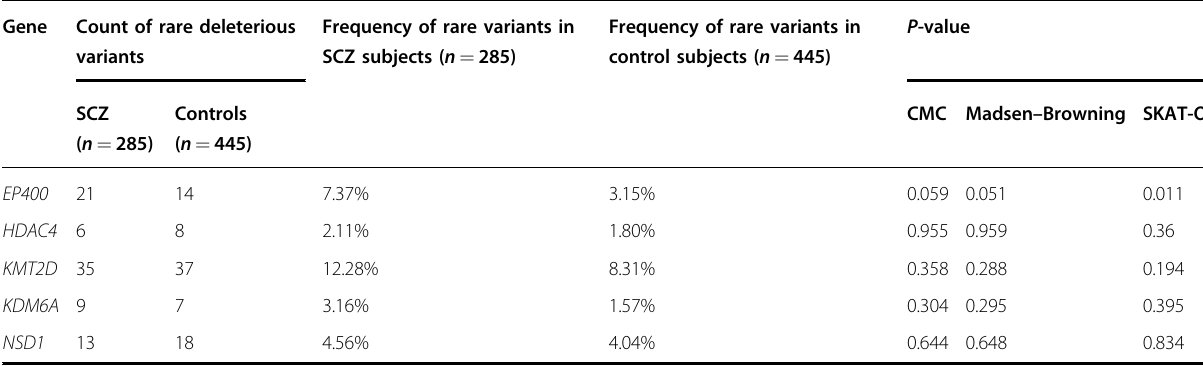
Table 2 Rare variants in gene-based burden tests for EP400